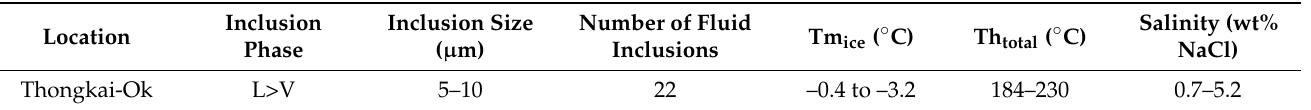
Table 1. Summary of microthermometry of fluid inclusions trapped in vein quartz from the Thongkai- Ok deposit.